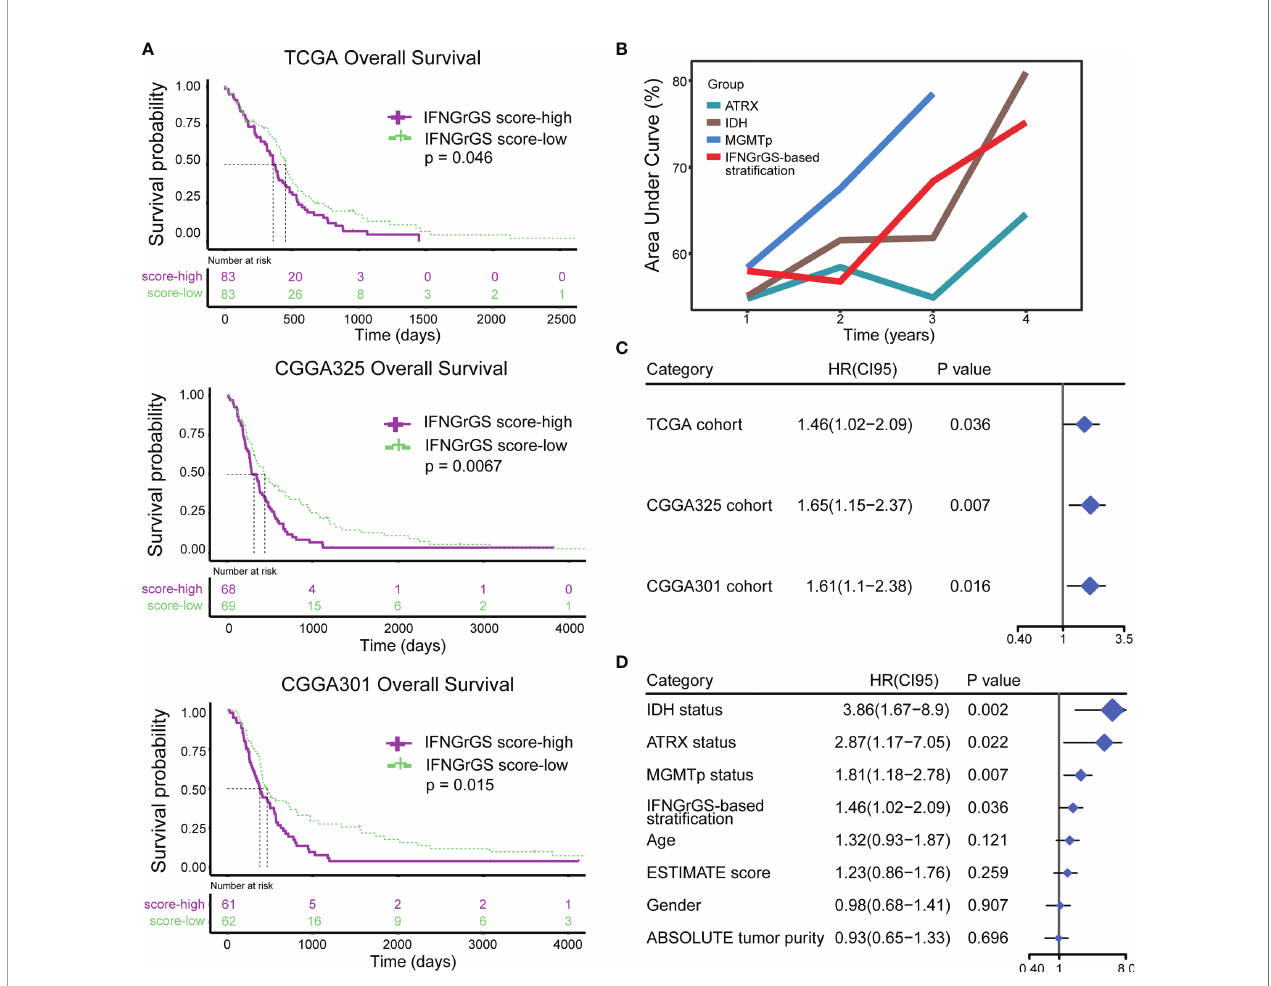
FIGURE 6 | Exploration and validation of the prognostic value of IFNGrGS-based strati fi cation. (A) The K-M plots showing the differences in overall survival between the IFNGrGS score-high and -low groups. (B) Time-dependent ROC analysis and corresponding AUC values of IDH status (wildtype vs . mutant), ATRX status (wildtype vs . mutant), MGMT promoter methylation status (unmethylated vs . methylated), and IFNGrGS-based strati fi cation (IFNGrGS score-high vs . IFNGrGS score- low). (C) The independent prognostic value of the IFNGrGS-based strati fi cation (IFNGrGS score-high vs . IFNGrGS score-low) based on the univariate Cox regression analysis. (D) Comparison of the independent prognostic value of IFNGrGS-based strati fi cation with other molecular pathology parameters based on the TCGA cohort. IDH status: wildtype vs . mutant; ATRX status: wildtype vs . mutant; MGMTp status: unmethylated vs . methylated; Age: > 60 vs . <= 60; Gender: male vs . female; ESTIMATE score and ABSOLUTE tumor purity: high vs low, with the median value being the